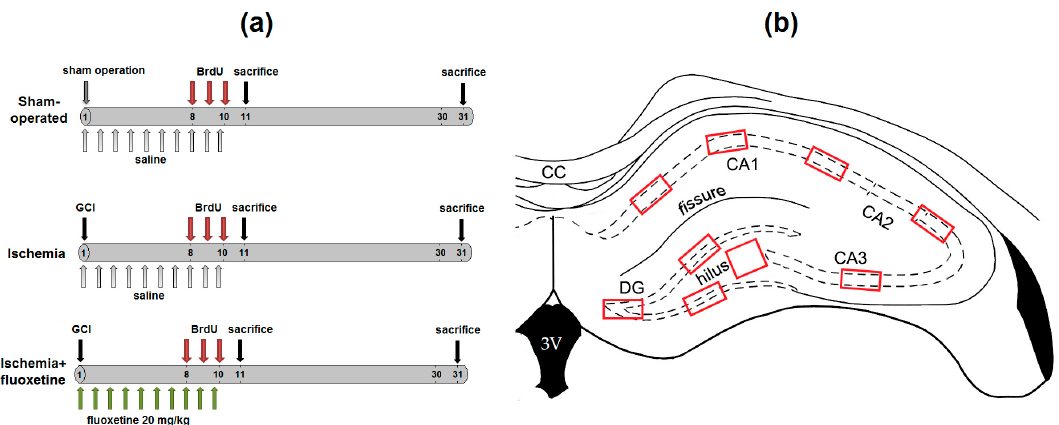
Figure 7. ( a ) Experimental design of the study; ( b ) Scheme of NeuN+ cells counting to quantify severity of the ischemic lesion in experimental animals.